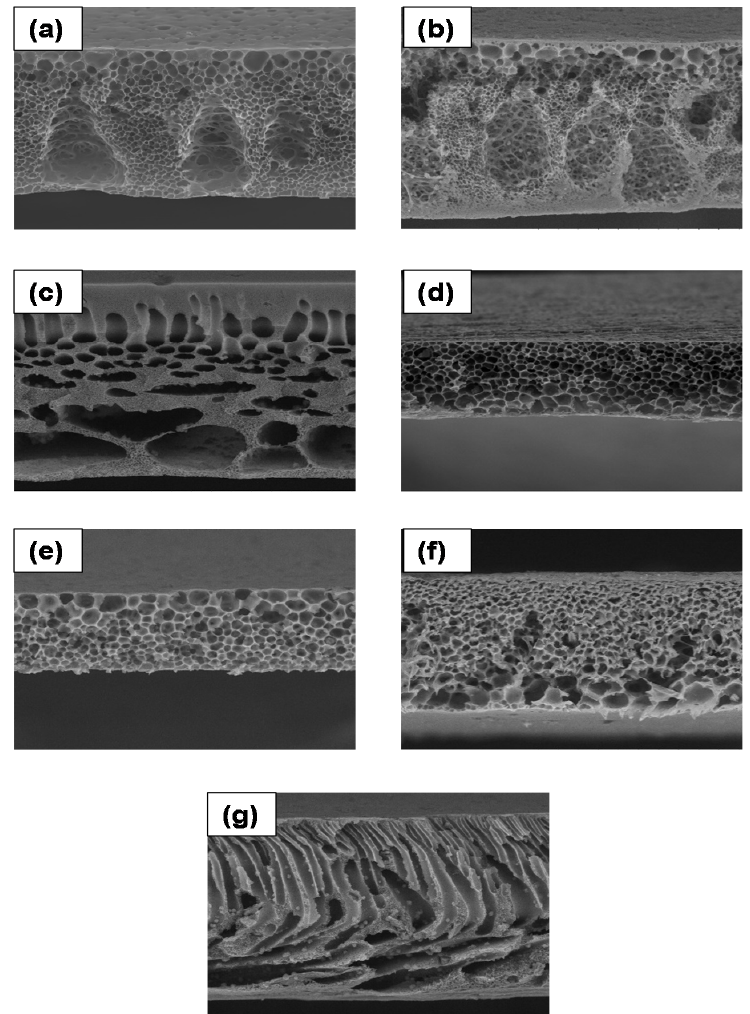
Figure 4. SEM images of cross section of PES/LSMM/OGCN membranes at 1000× magnification: ( a ) PES18wt%; ( b ) PES/LSMM ‐ OGCN0wt%; ( c ) PES/LSMM ‐ OGCN0.5wt%; ( d ) PES/LSMM ‐ OGCN1.0wt%; ( e ) PES/LSMM ‐ OGCN1.5wt%; ( f ) PES/LSMM ‐ OGCN2.0wt%; and ( g ) PES/LSMM ‐ OGCN2.5wt%.